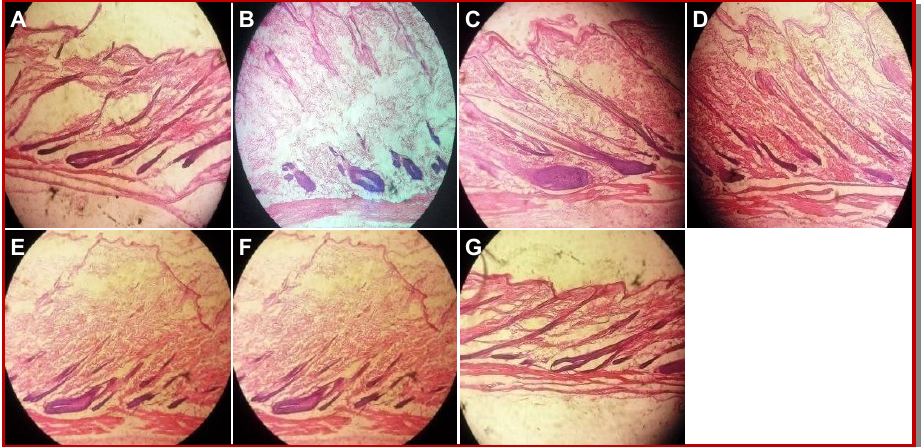
Figure 3: Photomicrograph retrieved on day 20 of experiment; A: normal control, B: disease control, C: standard, D: 5% N. sativa decoction, E: 10% N. sativa decoction, F: 15% N. sativa decoction, G: N. sativa oil